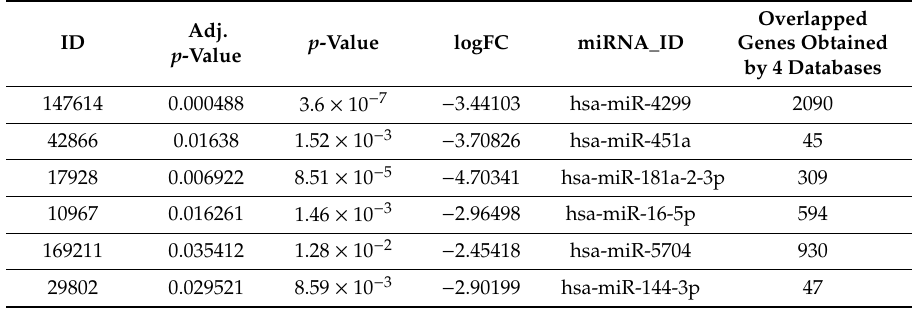
Table 1. Top 10 DEMs (7 downregulated and 3 upregulated) on the basis of log fold change and p -value. Upregulated miRs are miR-4634, miR-4638-5p, and miR-4769-5p and downregulated miRs